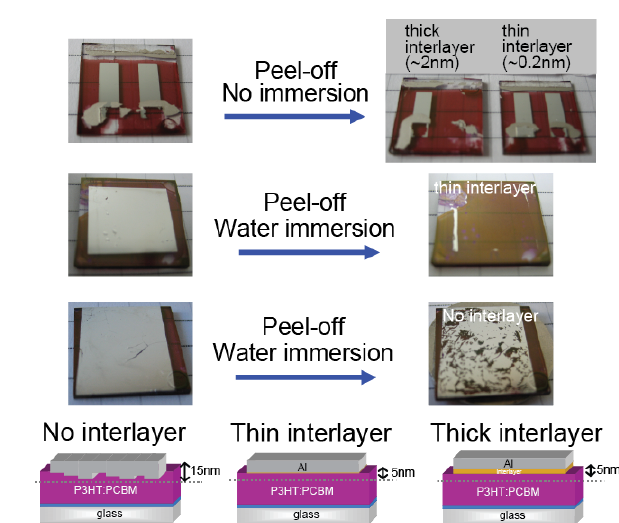
Figure 7. Effect of interlayer thickness on interfacial interaction zone and peeling. Optical micro- graphs of complete devices before ( left ) and after ( right ) Scotch tape peeling for various interlayers. At the bottom are schematic models of the interfacial interaction zone and nature of the electrode interface. Reprinted from Ref. [12], copyright (2019) with permission from